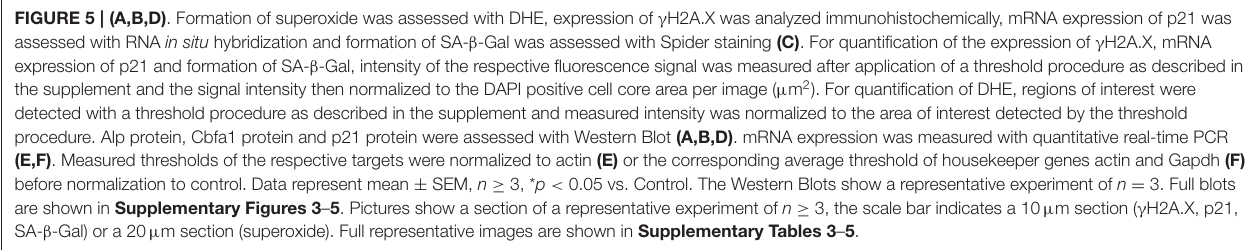
FIGURE 5 | (A,B,D) . Formation of superoxide was assessed with DHE, expression of γ H2A.X was analyzed immunohistochemically, mRNA expression of p21 was assessed with RNA in situ hybridization and formation of SA- β -Gal was assessed with Spider staining (C) . For quantification of the expression of γ H2A.X, mRNA expression of p21 and formation of SA- β -Gal, intensity of the respective fluorescence signal was measured after application of a threshold procedure as described in the supplement and the signal intensity then normalized to the DAPI positive cell core area per image ( µ m 2 ). For quantification of DHE, regions of interest were detected with a threshold procedure as described in the supplement and measured intensity was normalized to the area of interest detected by the threshold procedure. Alp protein, Cbfa1 protein and p21 protein were assessed with Western Blot (A,B,D) . mRNA expression was measured with quantitative real-time PCR (E,F) . Measured thresholds of the respective targets were normalized to actin (E) or the corresponding average threshold of housekeeper genes actin and Gapdh (F) before normalization to control. Data represent mean ± SEM, n ≥ 3, * p < 0.05 vs. Control. The Western Blots show a representative experiment of n = 3. Full blots